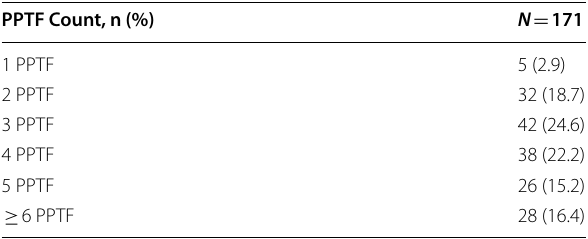
Table 2 Prior prophylactic treatment Failures by count and percentage